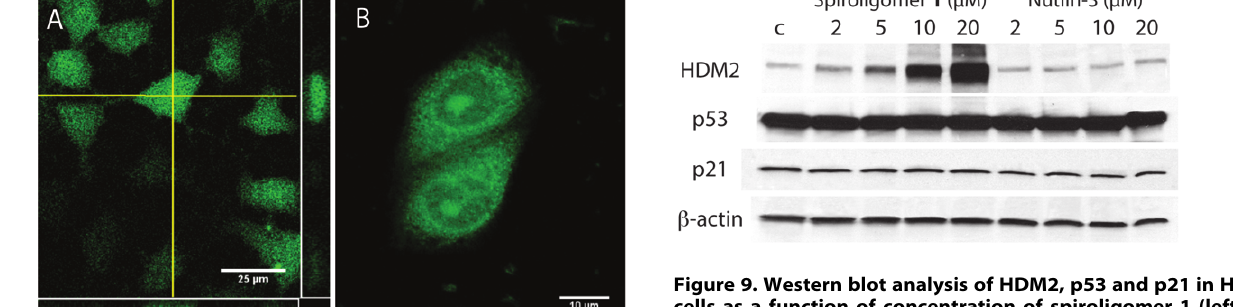
Figure 9. Western blot analysis of HDM2, p53 and p21 in Huh7 cells as a function of concentration of spiroligomer 1 (left) or Nutlin-3